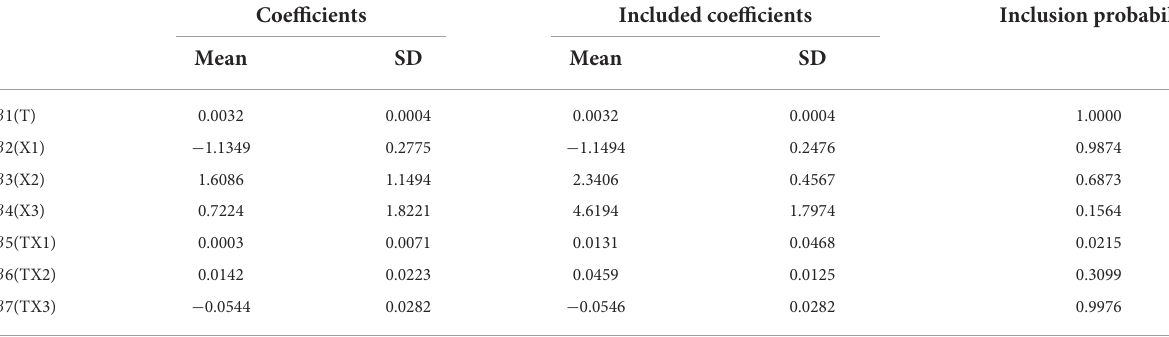
TABLE 2 Regression coefficients of variables in the interrupted time series